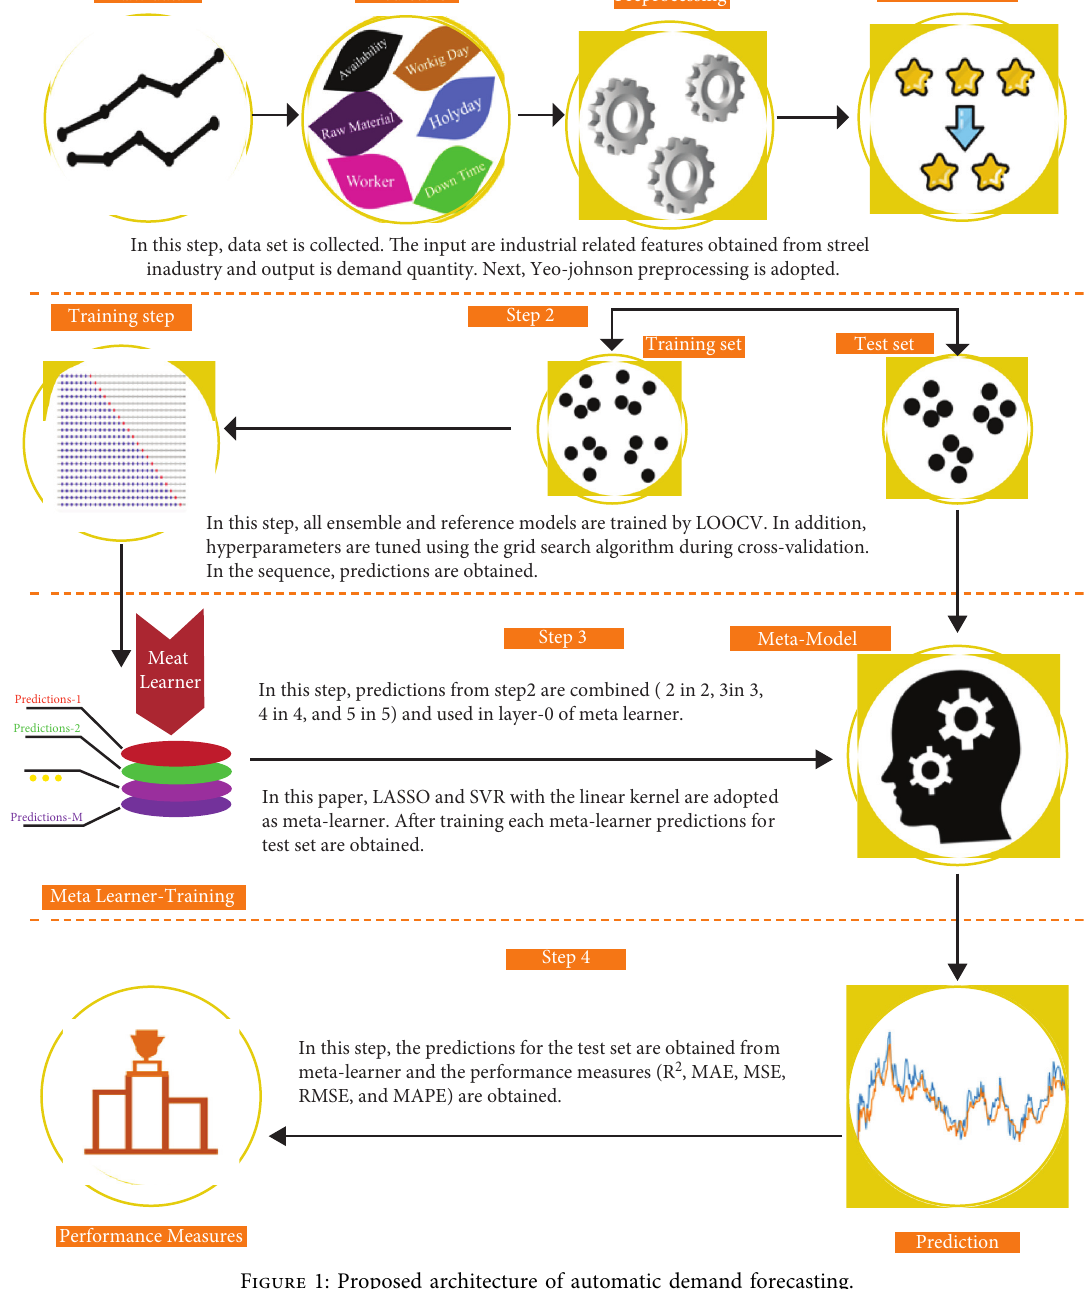
Figure 1: Proposed architecture of automatic demand